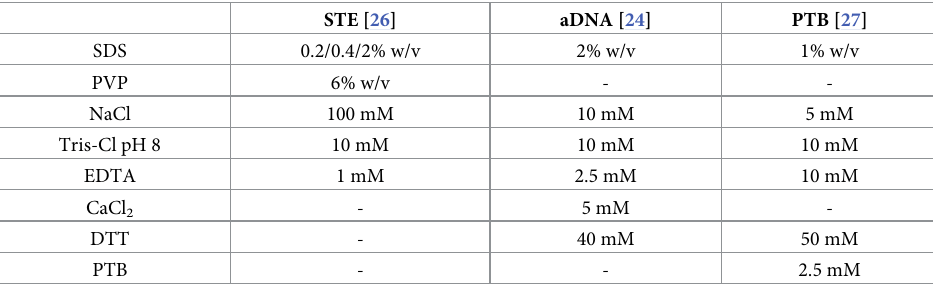
Table 3. DNA extraction